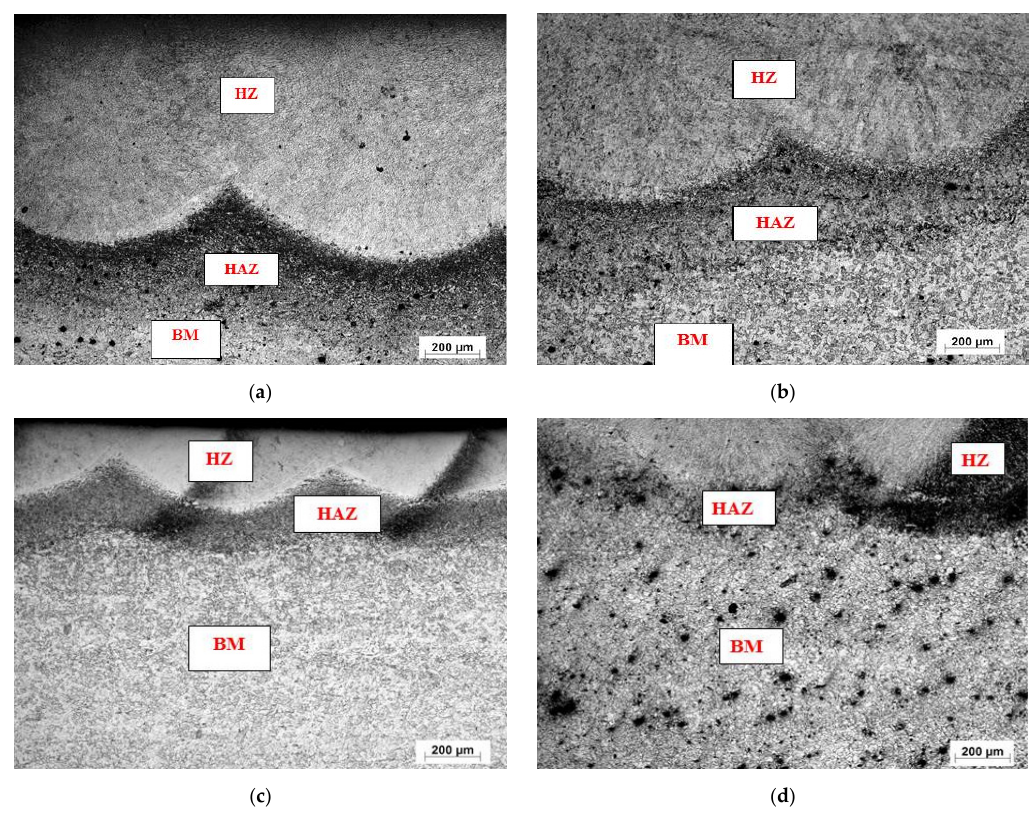
Figure 5. Typical microstructure features (magnification 50 × ) of laser heat treated (LHT) AISI 416 stainless steel at a constant power of 1000 W and different laser scanning speeds: ( a ) 0.5; ( b ) 1; ( c ) 2; and ( d ) 3 m · min − 1